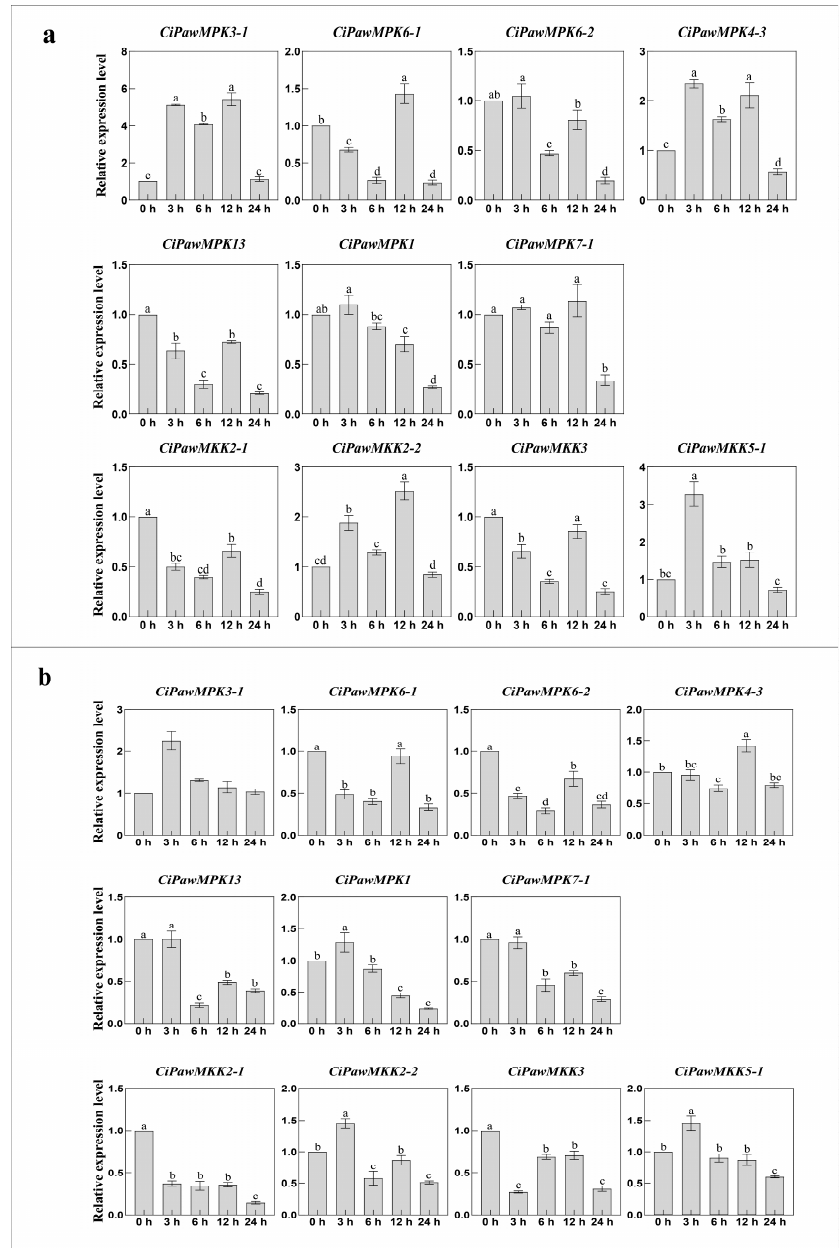
Figure 9. Gene expression patterns of MPK and MKK in pecan under MeJA ( a ) and 6-BA ( b ) treat- ments. The reference gene is the actin gene ( CiPaw.03G124400 ). The horizontal coordinates indicate the different time points sampled and the vertical coordinates indicate the expression level of the genes. According to Duncan’s multiple range test, it was judged whether there was a significant difference in the expression levels at different time points ( p < 0.05), and the difference results were denoted by lowercase letters. Error bars represent mean ± SE obtained from three biological repli- cates.